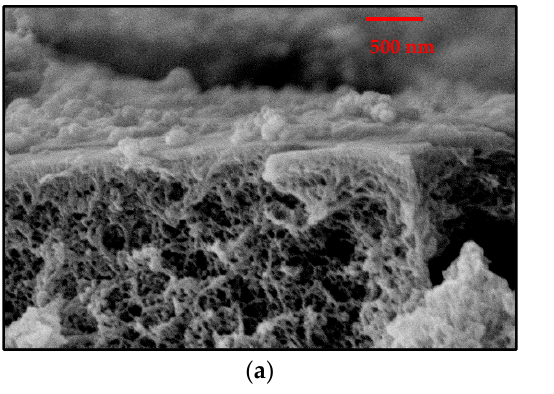
Figure 7. Cross-section SEM images of composite membranes obtained by using different solu- tions/dispersions for coating: ( a ) 0.25 g/L PSSA particles, 0.5 g/L PEI, and 1 g/L GDE; ( b ) 0.5 g/L PSSA particles, 0.5 g/L PEI, and 1 g/L GDE.